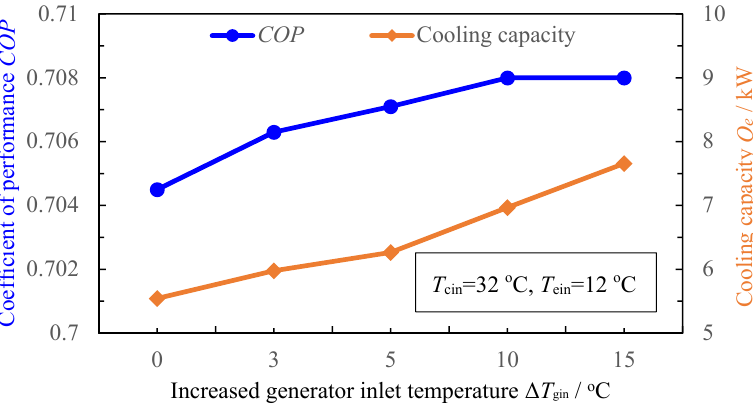
Figure 6. The effect of different Δ T gin on the COP and cooling capacity.